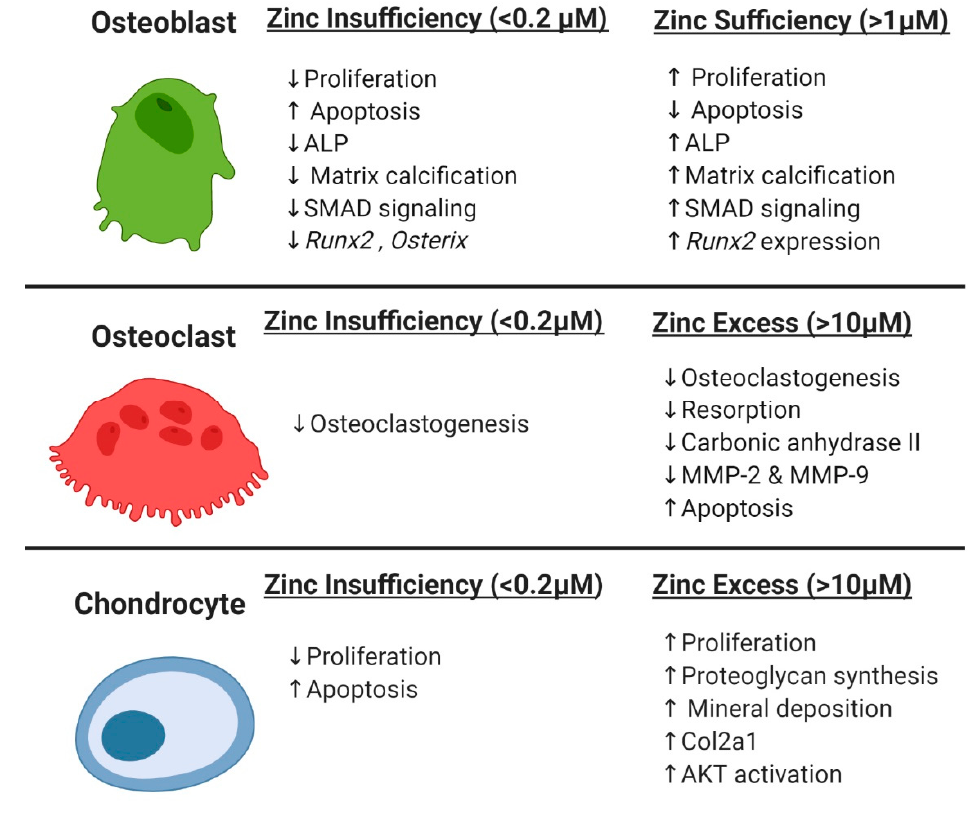
Figure 2. Zinc E ff ects on Skeletal Figure 2. Zinc Effects on Skeletal Cells.